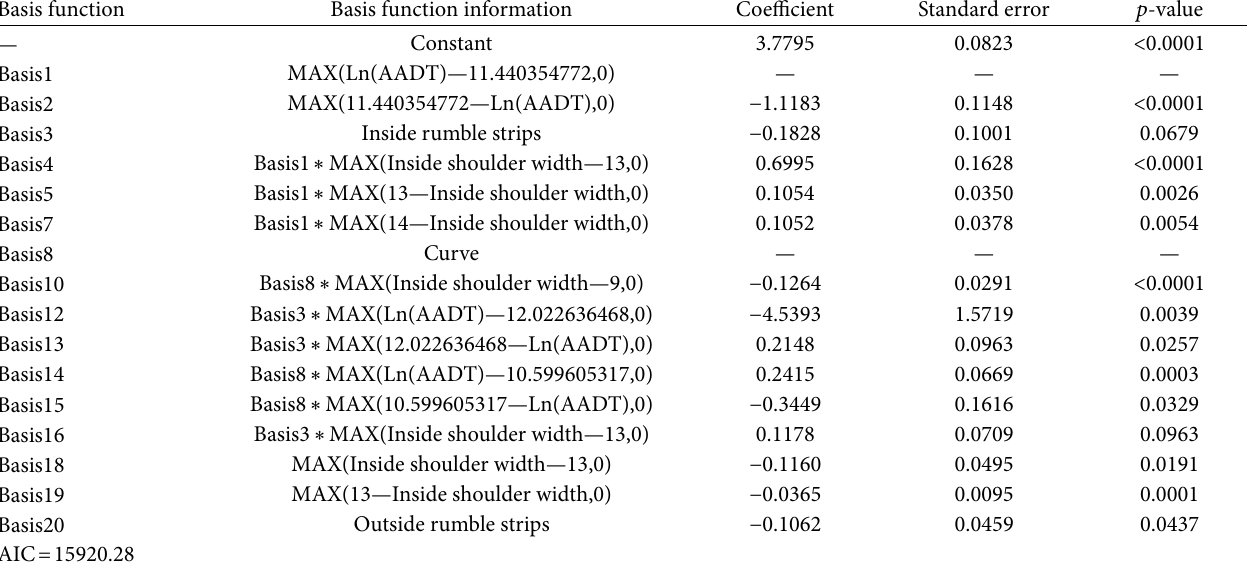
Table 3: MARS model for total crashes.